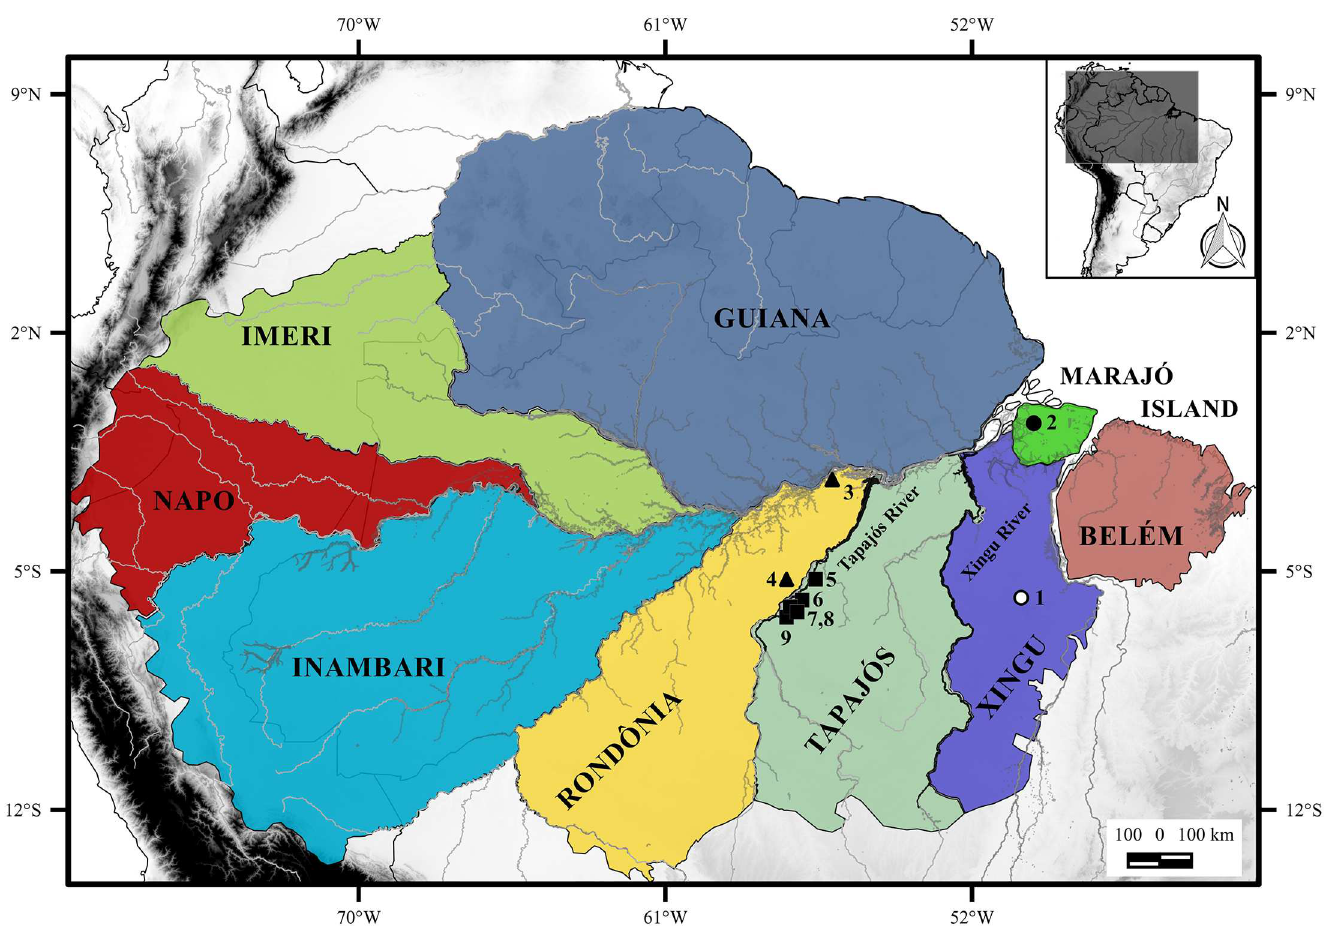
Fig 1. Amazon endemic areas based on the distribution of terrestrial vertebrates [5]. Collectionpoints of Neacomys sp. A (NSP-A; Black square), Neacomys sp. B (NSP-B; black triangle)and Neacomys sp. (white and black circle) [28]. Tapajo´s and Xingu Rivers are highlighted in black. The numbers refer to localities mentioned in S1 Table. (1) Maraba´; (2) Chaves, Marajo´ island; (3) Juruti; (4, 5, 6 and 8) Itaituba; (7 and 9) Jacareacanga, all in Para´ state, Brazil.